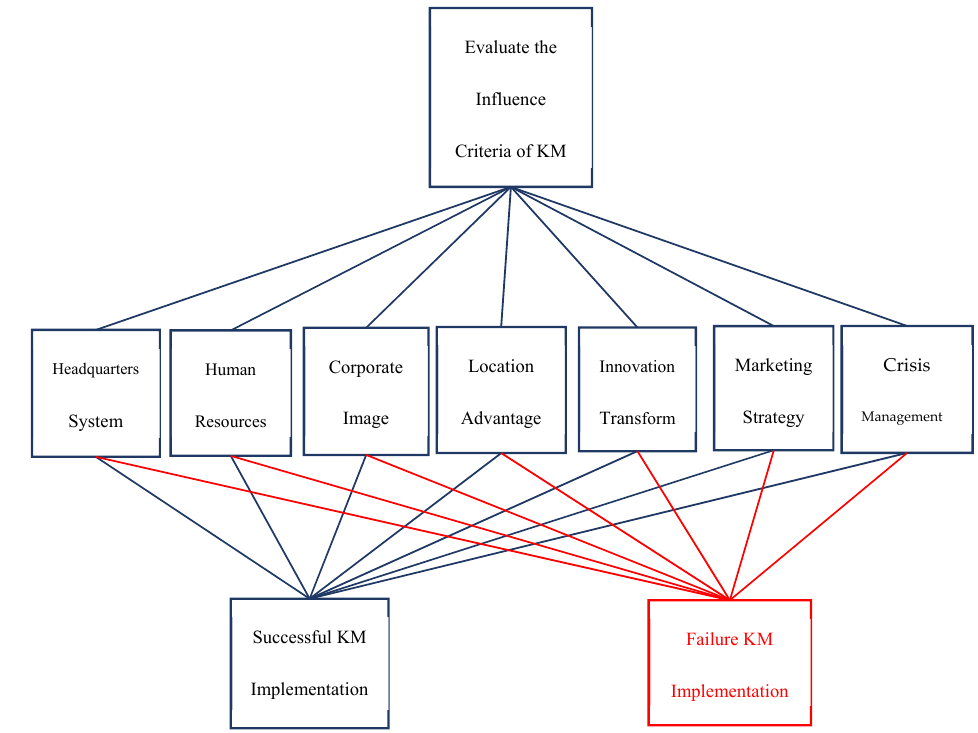
Figure 2. The analytical hierarchy framework. Source: Hsieh et al. (2020).